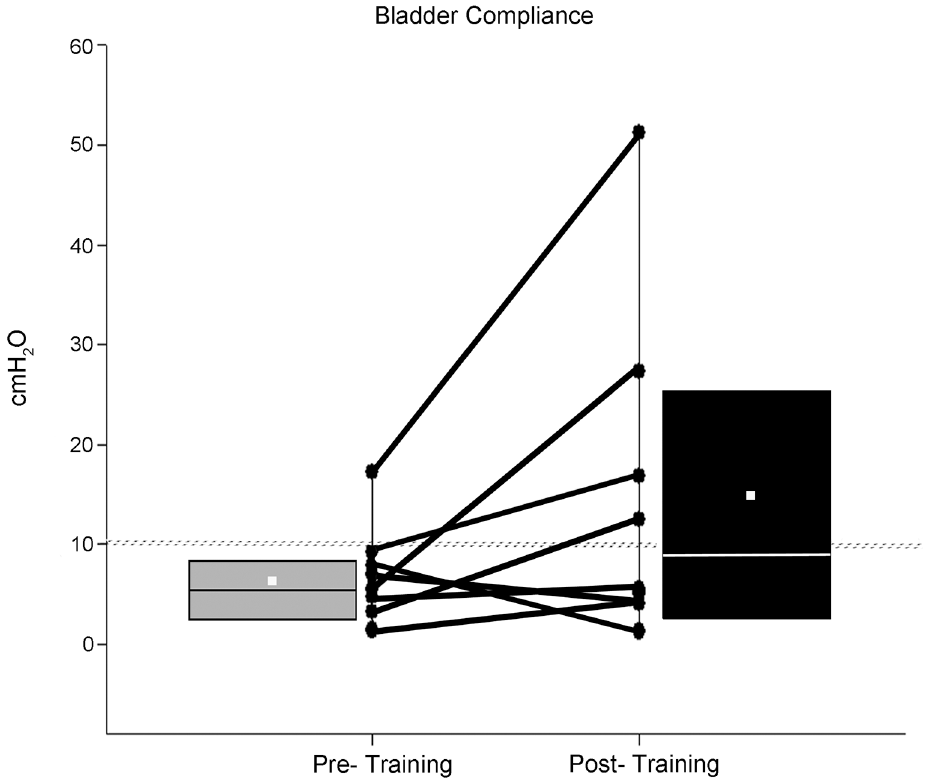
Fig 8. Bladder compliance data summary. Most research participants (85%) had low compliance ( < 10 cmH 2 O - Δ P/ Δ V) at the pre-training baseline cystometric recording. However, post-training, 50% showed an improvement in bladder filling under lower pressures. A ranking and average of the compliance values at the pre-training time point indicate a median (horizontal line) and mean (small white square) value of 6.3 and 7.0 ± 4.8 cm/H 2 O, respectively, while post training, the median and mean values were 9.0 and 15.5 ± 16.8 cm/H 2 O, respectively (p > .05).